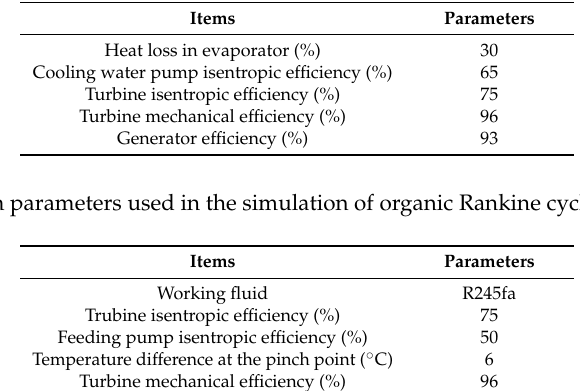
Table 1. System parameters used in the simulation of flash power generation systems.